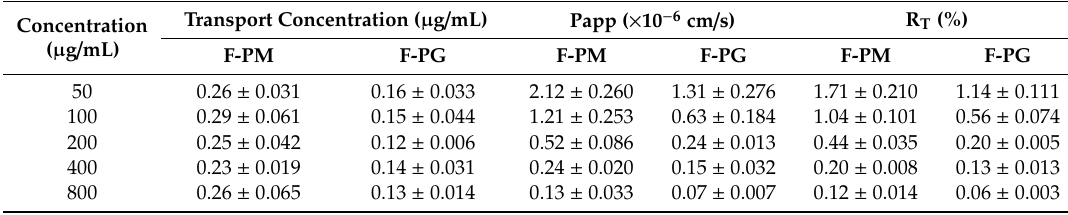
Table 8. Translocation of F-PM and F-PG at di ff erent